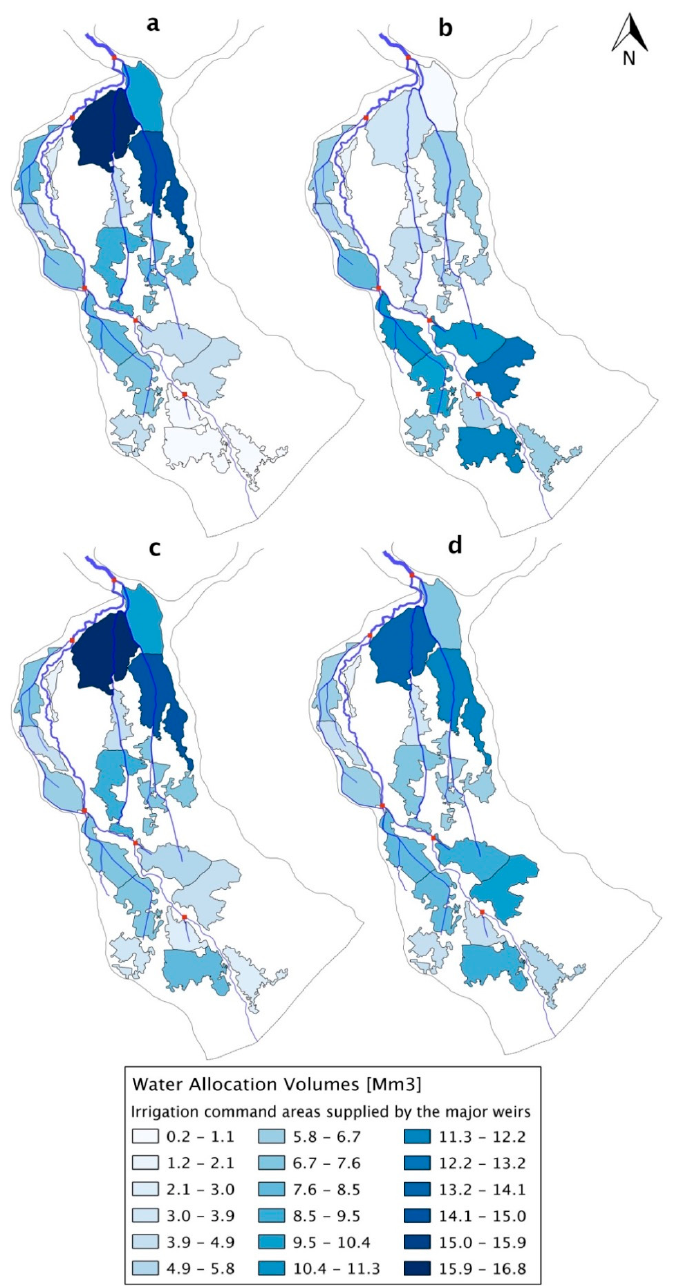
Figure 4. Average annual water allocation in million cubic metres for the four allocation scenarios: ( a ) upstream; ( b ) downstream; ( c ) mixed; and ( d ) equal priorities. Table 2. Average percentage of water demand satisfied over the 15-year simulation.